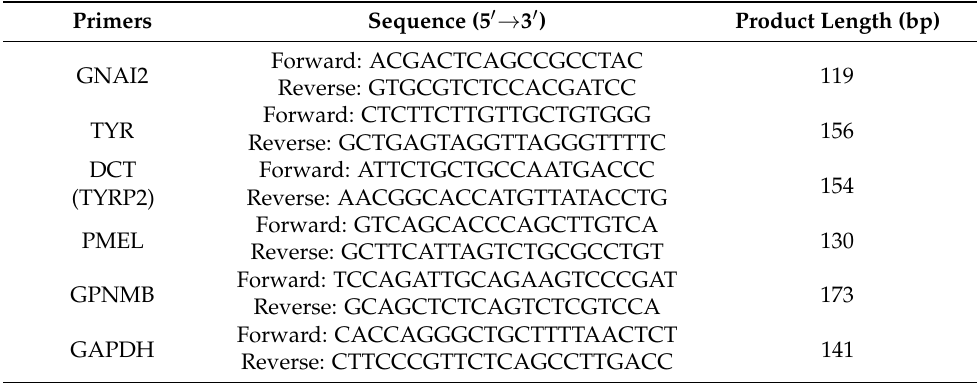
Table 3. qRT-PCR primer